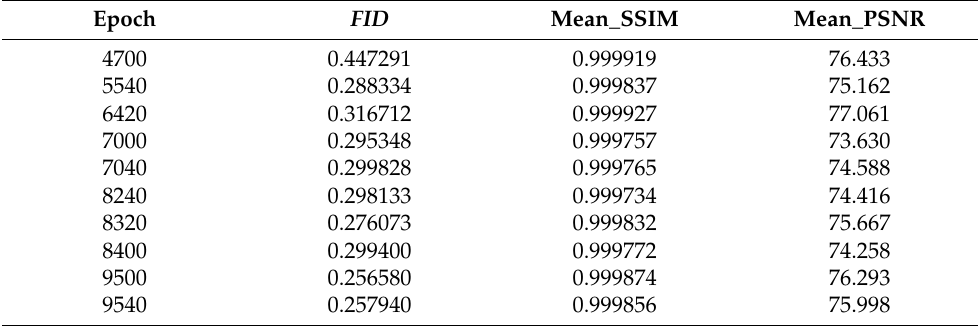
Table 6. The training values of FID , Mean_SSIM and Mean_PSNR of the WAR model.